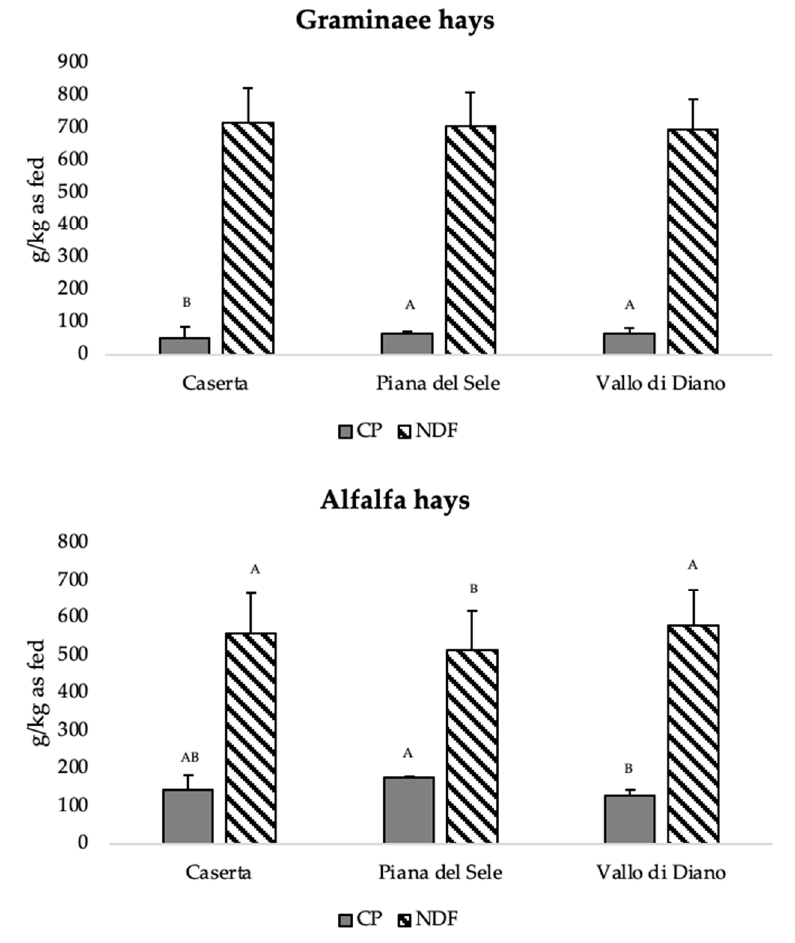
Figure 3. Crude protein and neutral detergent fiber content of the analyzed hays (polyphite, Gramineae and alfalfa) comparing the different sampling areas. CP, crude protein; NDF, neutral detergent fiber; A and B, different letters indicate statistically significant differences at 1%.